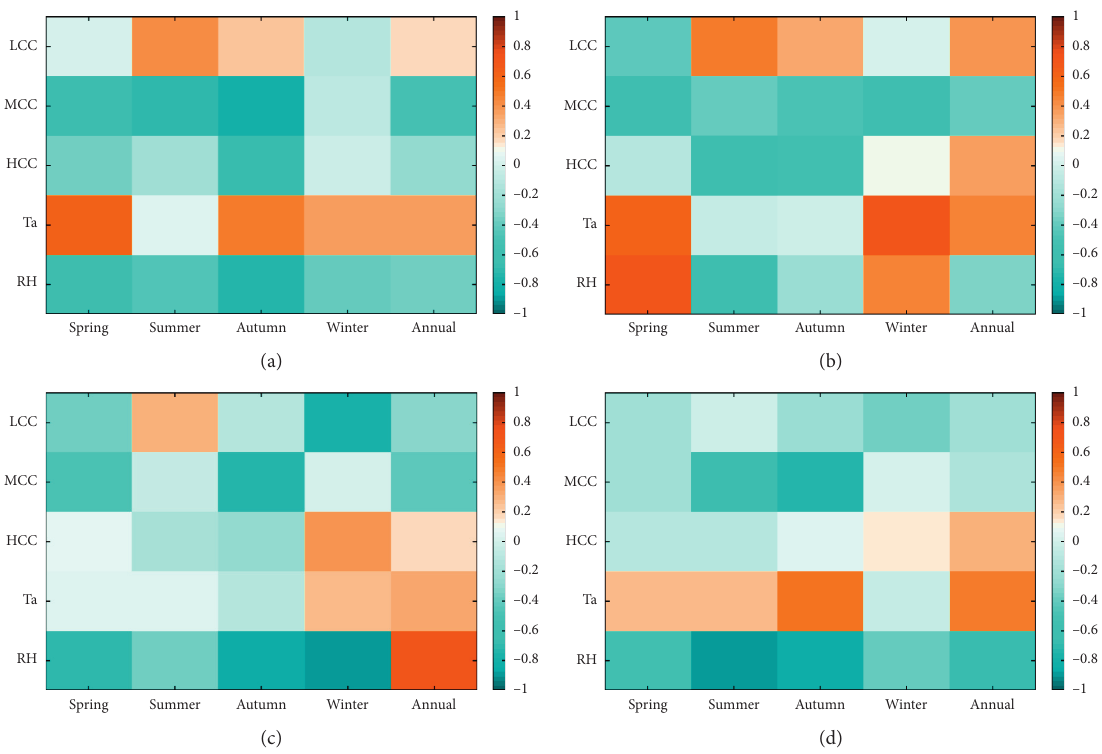
Figure 13: Correlation coefficients between all-sky LER and HCC, MCC, LCC, T a , and RH in different regions and seasons during the period 2001–2016. (a) Region 1. (b) Region 2. (c) Region 3. (d) Region 4. The absolute value above 0.49 is proven at a 95% significance